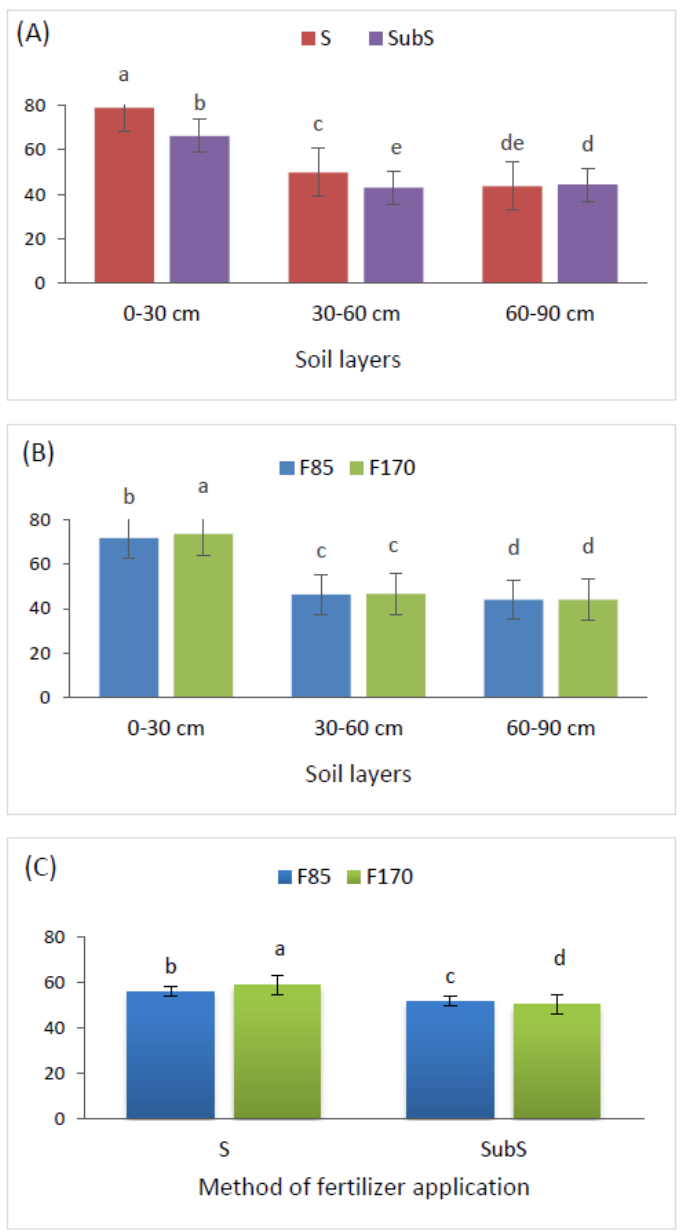
Figure 4. Effect of the interaction of the experimental factors on the soil content of available K [mg ∙ kg − 1 ]: ( A ) Method of fertilizer application × soil layer; ( B ) Fertilizer dose × soil layer; ( C ) Method of fertilizer application × fertilizer dose (S—Surface fertilizer application, SubS—Subsurface fertilizer application; F85—fertilizer dose 85 kg NPKS ∙ ha − 1 ; F170—fertilizer dose 170 kg NPKS ∙ ha − 1 ); different letters indicate significant difference ( p = 0.05).